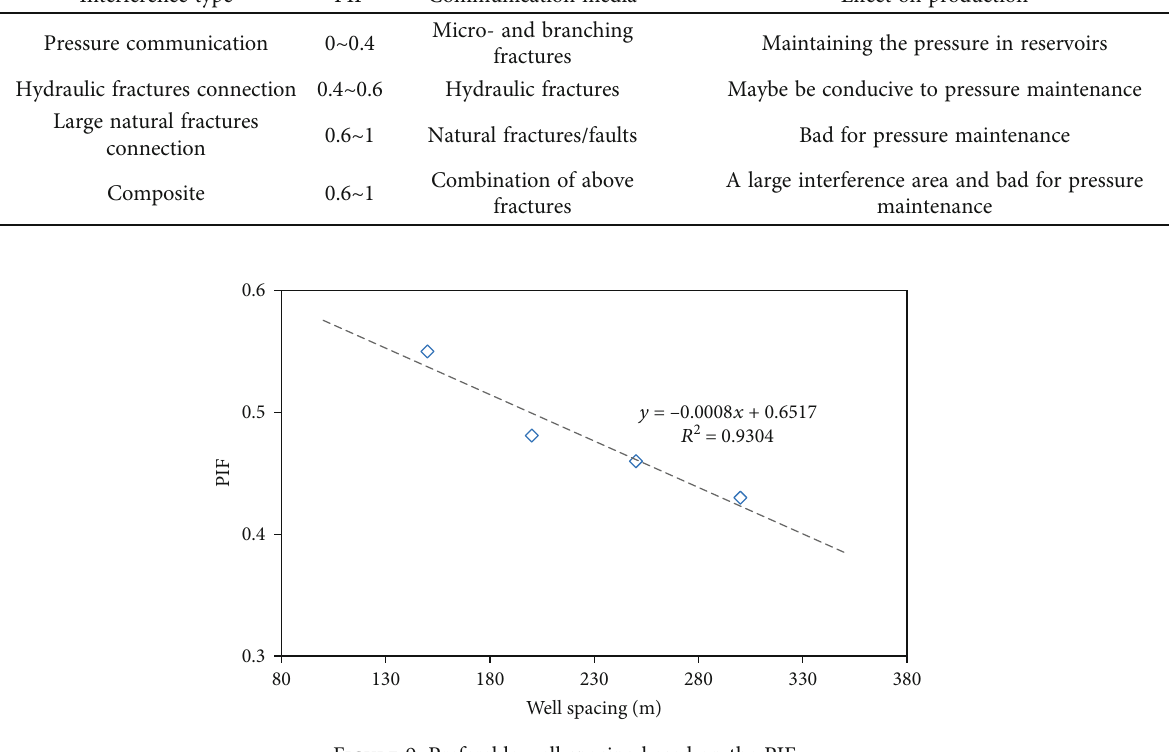
Figure 9: Preferable well spacing based on the PIF.